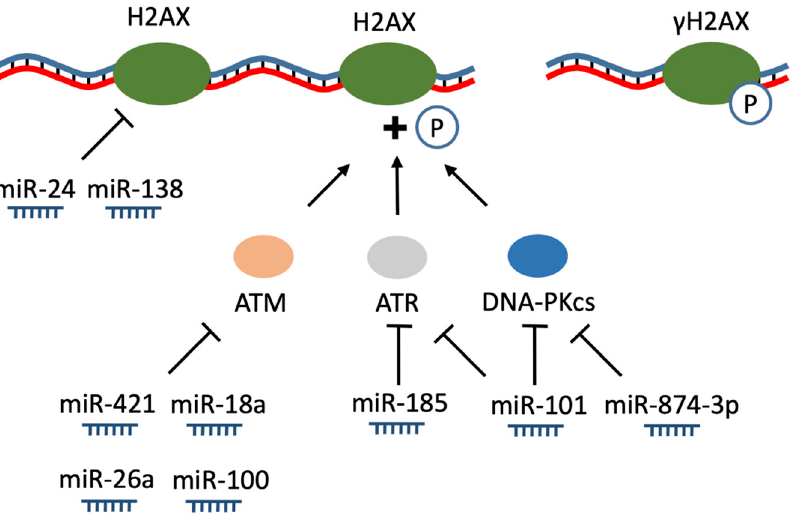
Figure 2. miRNA regulation of DNA-damage recognition. miRNAs affect the process of histone phosphorylation controlling both the mRNA level of the H2A histone family member X (H2AX) itself and expression of protein kinases: phosphoinositide 3-kinase (PI3K)-related ataxia telangiectasia mutated protein kinase (ATM), ataxia telangiectasia and Rad3 related protein kinase (ATR) and DNA-dependent protein kinase, catalytic subunit (DNA-PKcs). MiR-24 and mir-138 suppress H2AX expression and inhibiting γ H2AX foci formation. Synthesis of ATM is suppressed by miR-18a, miR-421, miR-26a and miR-100. miR-185 targets ATR, miR-874-3p inhibits expression of DNA-PKcs, miR-101 binds to both DNA-PKcs and ATM